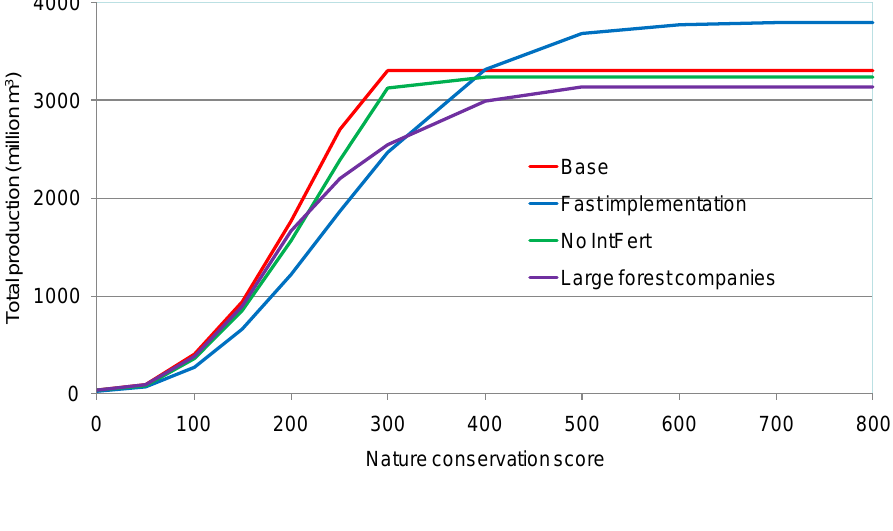
Figure 5. Total accumulated volume production (million m 3 ) during the simulated 100-year simulation versus the nature conservation score (NCS), under the four intensive forest management (IFM) scenarios. The nature conservation scores are positively correlated with nature conservation